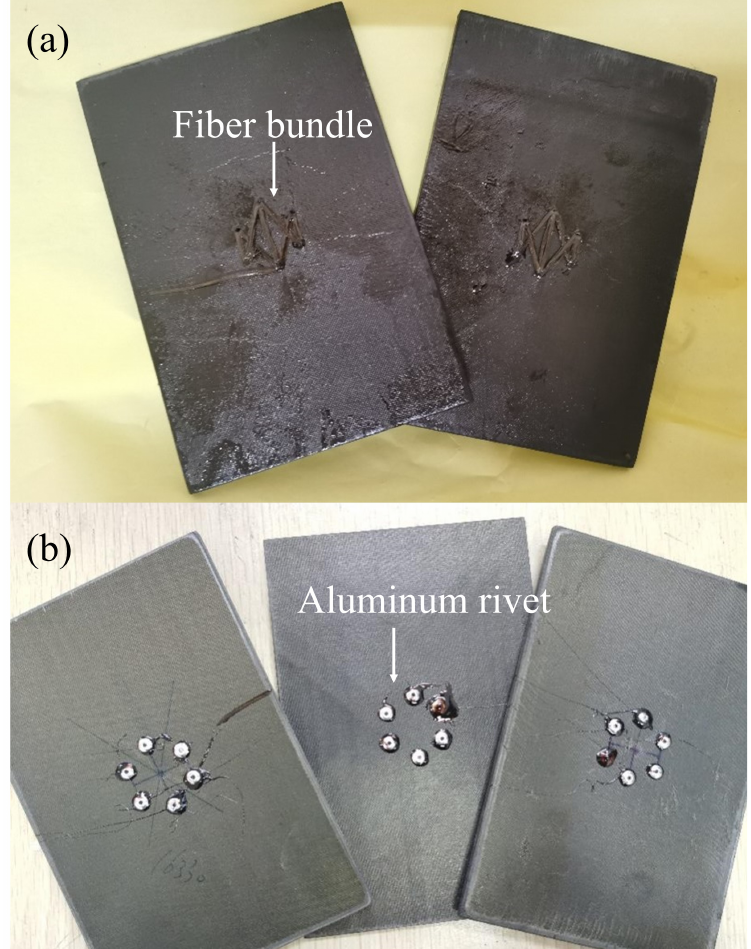
Figure 5. Photograph of plates after ( a ) stitching repair and ( b ) riveting